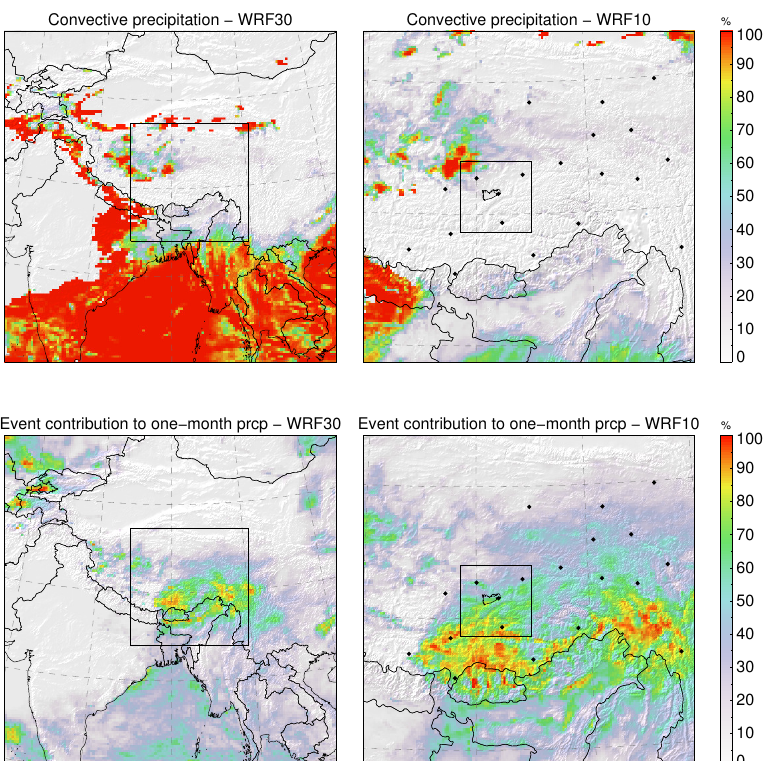
Fig. 10. Top: contribution of convective precipitation to the total precipitation for the one-week simulation period of the Rashmi event. Bottom: contribution of precipitation caused by the Rashmi event to monthly precipitation in October 2008.